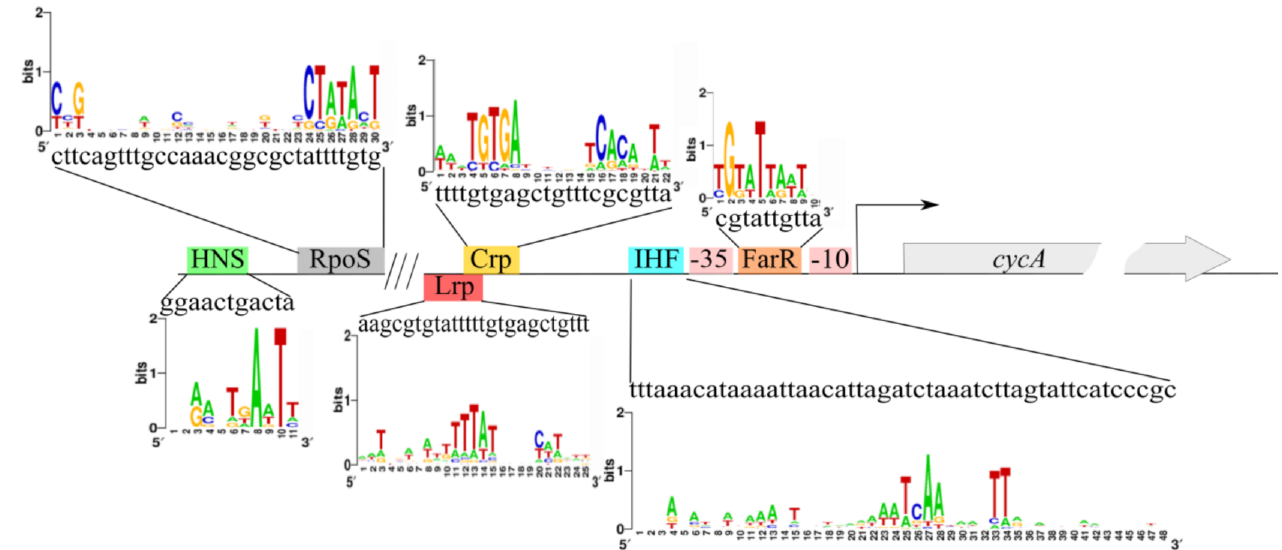
Figure 5. Schematic view of cycA regulatory region with the binding sites of putative transcription factors predicted using a bioinformatics approach. Sequence logos were created using the web-based application WebLogo (http://weblogo.berkeley.edu/, accessed on 19 October